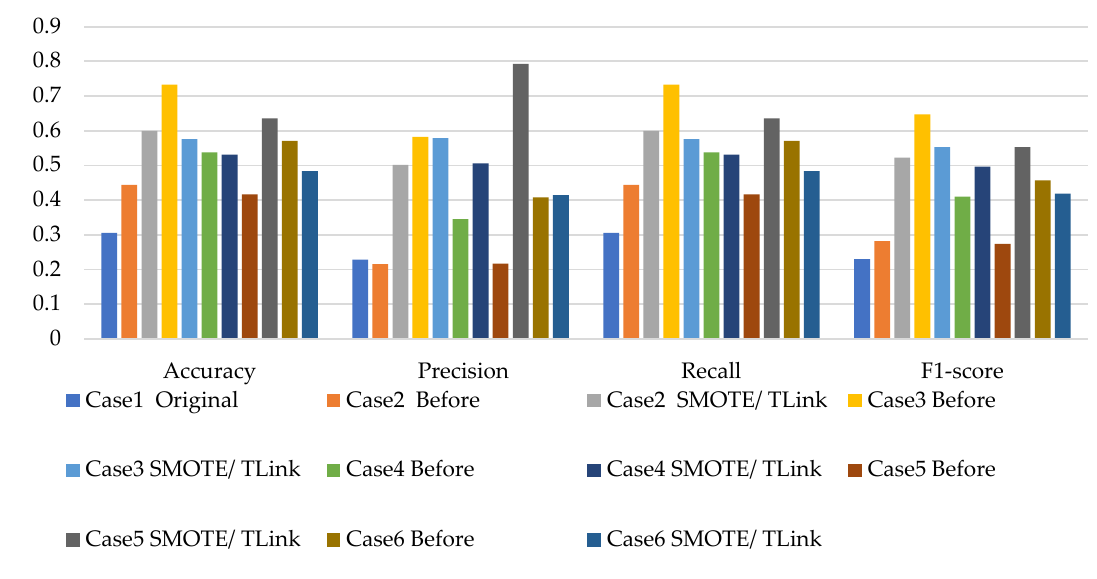
Figure 10. Simulation performance of SVM classification with SOMTE/T-link.